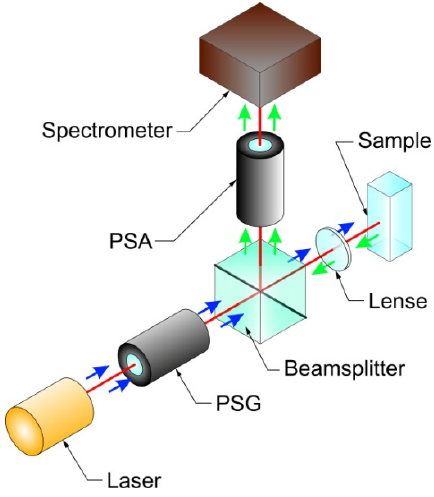
Figure 5. Typical layout of MM fluorescence spectrometer.